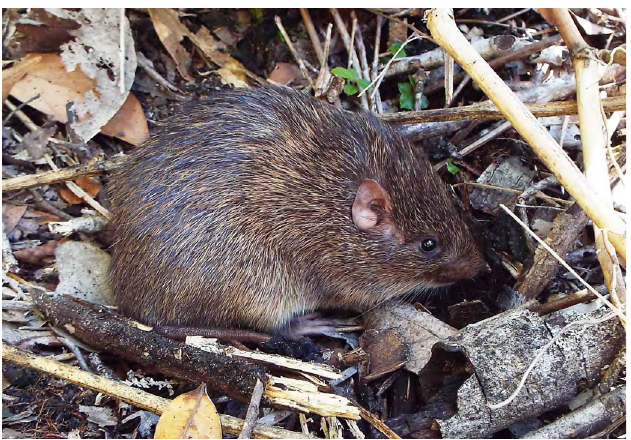
Figure 4. Dorsal and ventral views of the skull of Euryzygomatomys spi- nosus (MDIA 078) collected at Sempre Vivas National Park, Minas Gerais, Brazil. Photo by Pacheco MAC. Scale bar = 20 mm.